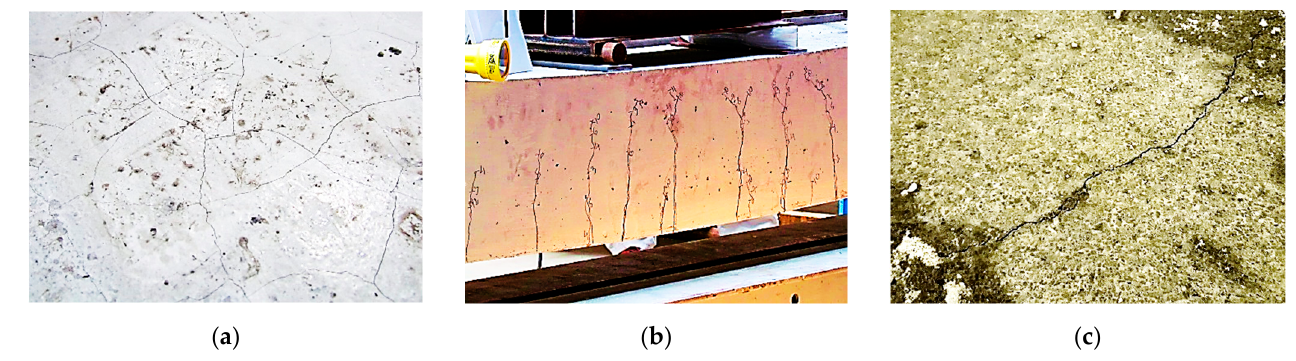
Figure 3. ( a ) Irregular thermal-shrinkage cracks within the surface of the slab; ( b ) multiple cracks within the tension zone of the bent beam; ( c ) single crack in the concrete road.